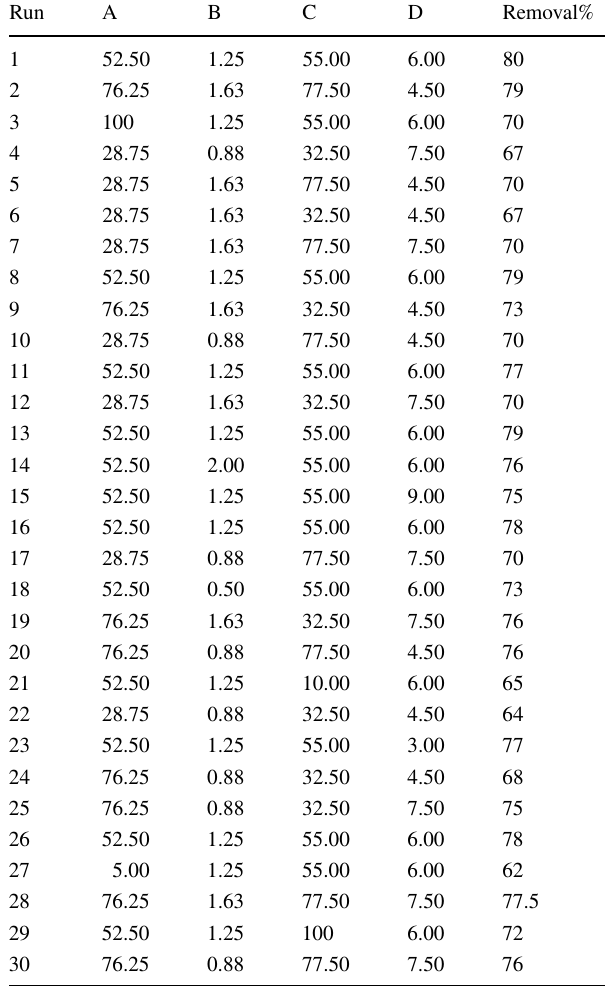
Table 3 Experimental design and dye removal percentage through the adsorption AG 20 onto